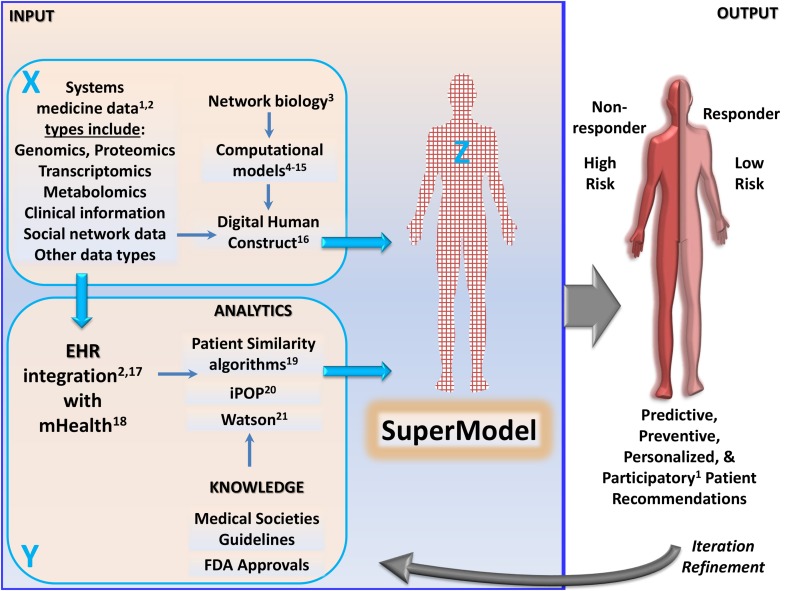
Building SuperModels for precision and systems medicine, with incorporation of computational avatars. Input: A feedforward loop (top left panel X connects to patient avatar Z both indirectly via bottom left panel Y and also directly, by large blue arrows) is fueled by two disparate paths. In the top left panel labeled X, various systems medicine data types, along with network biology and emerging computational models (including genome-scale metabolic models, Agren et al., 2014; Yizhak et al., 2015), provide input for patient representations such as the digital human construct being developed by The Discipulus Project. In the bottom left panel labeled Y, systems medicine data are integrated into patients' mobile health (mHealth) technologies and electronic health records (EHR) (Brown et al., 2015b). mHealth and EHR data are coupled with external knowledge [e.g., from medical societies guidelines and Food and Drug Administration (FDA) approvals] by cognitive machines such as Watson, and analytics are employed to process multi-omics (integrated personal omics profile; iPOP) and patient similarity algorithms. The path labeled Y is already in progress with EHR data, independent of digital human constructs described in the path labeled X. Paths X and Y can be bridged by locally supervised metric learning (LSML) similarity measures and similarity network fusions (SNF), for synergistic creation of SuperModels to produce results that cannot be obtained from path X or path Y alone. Output: High-yield predictive, preventive, and personalized data indicate patients at low/high risk for disease/adverse effect development. Individualized therapeutic plans can therefore be devised, also guided by the patient's likelihood of being a responder or non-responder to specific medications. Provision of personalized data should be in the context of systems medicine counseling, integrating genetic counseling with information about various forms of systems medicine data (Brown et al., 2015b). Iteration: The curved gray arrow linking output to input represents using outcome observations to iterate and refine SuperModels at all stages of development, to guide precision medicine. 1Hood and Flores (2012), 2Brown et al. (2015b), 3Barabási and Oltvai (2004), 4Schuyler et al. (2011), 5Plotkin et al. (2013), 6Bikson et al. (2012a), 7Brown and Loew (2014), 8Brown et al. (2015a), 9Henderson et al. (2014), 10Tortolina et al. (2012), 11Stamatakos et al. (2010), 12El-Kareh and Secomb (2000), 13Utsler (2015), 14Agren et al. (2014), 15Yizhak et al. (2015), 16The Discipulus Project (2013), 17Kullo et al. (2013), 18Steinhubl et al. (2015), 19Zhang et al. (2014), 20Chen et al. (2012), 21Savage (2014).